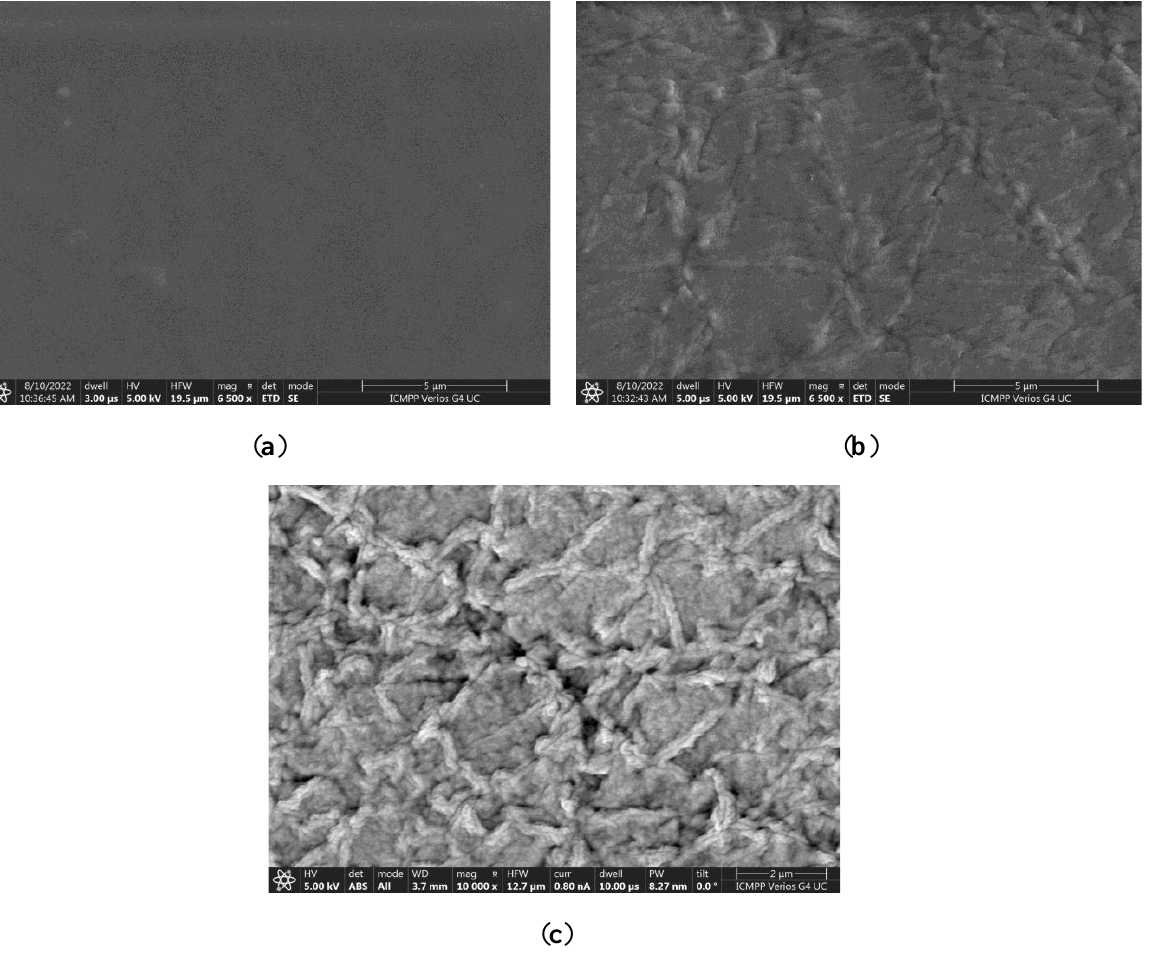
Figure 4. SEM microphotographs of C1 (free of Lap) ( a ) and C5 (with Lap) films were obtained at magnifications of 6500 × ( b ) and 10,000 × ( c ).